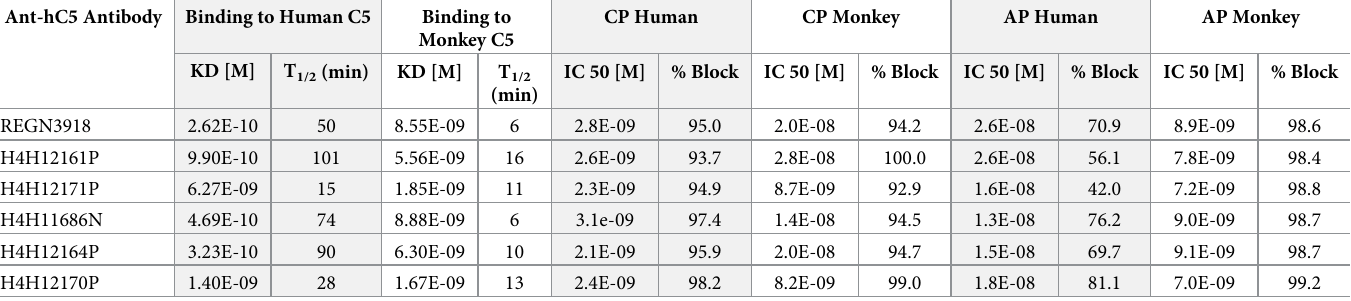
Table 1. Summary of kinetic properties for anti-C5 antibodies binding to human and cynomolgus monkey C5 at 37˚C, pH7.4 and blocking CP- and AP-mediated hemolysis in normal human and cynomolgus monkey serum ex vivo . Ant-hC5 Antibody Binding to Human